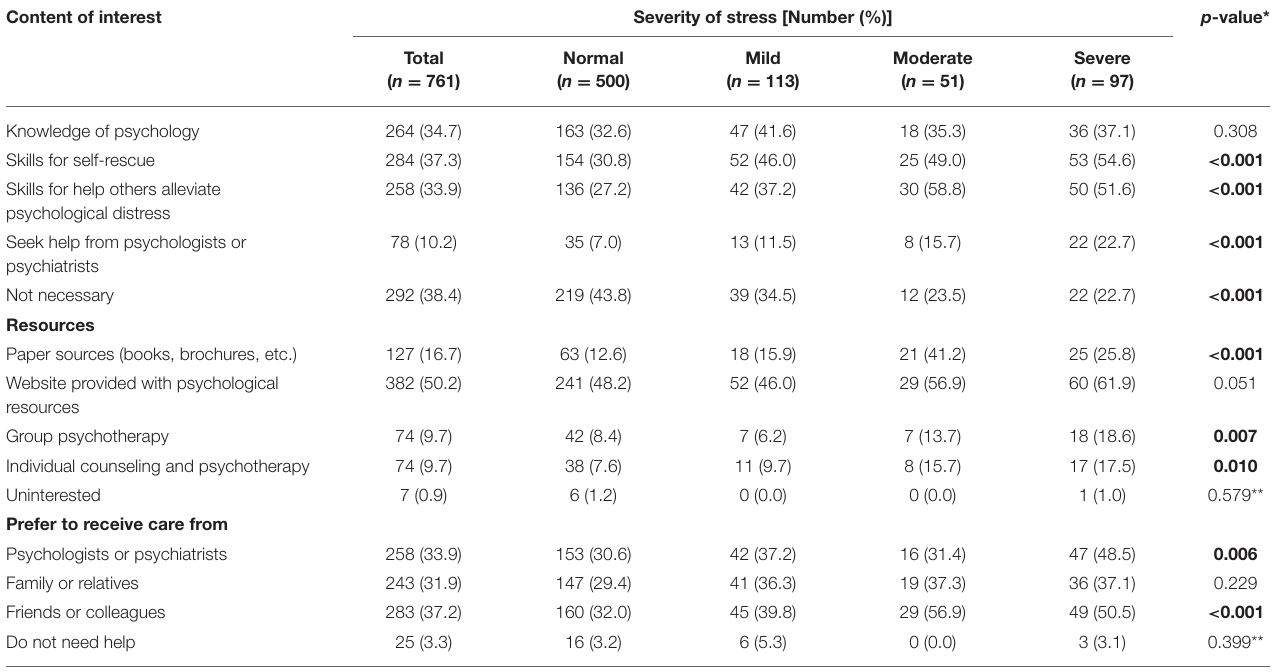
TABLE 3 | The association between stress severity level and needs of mental health support among HCWs during the COVID-19 outbreak in Vietnam. Content of